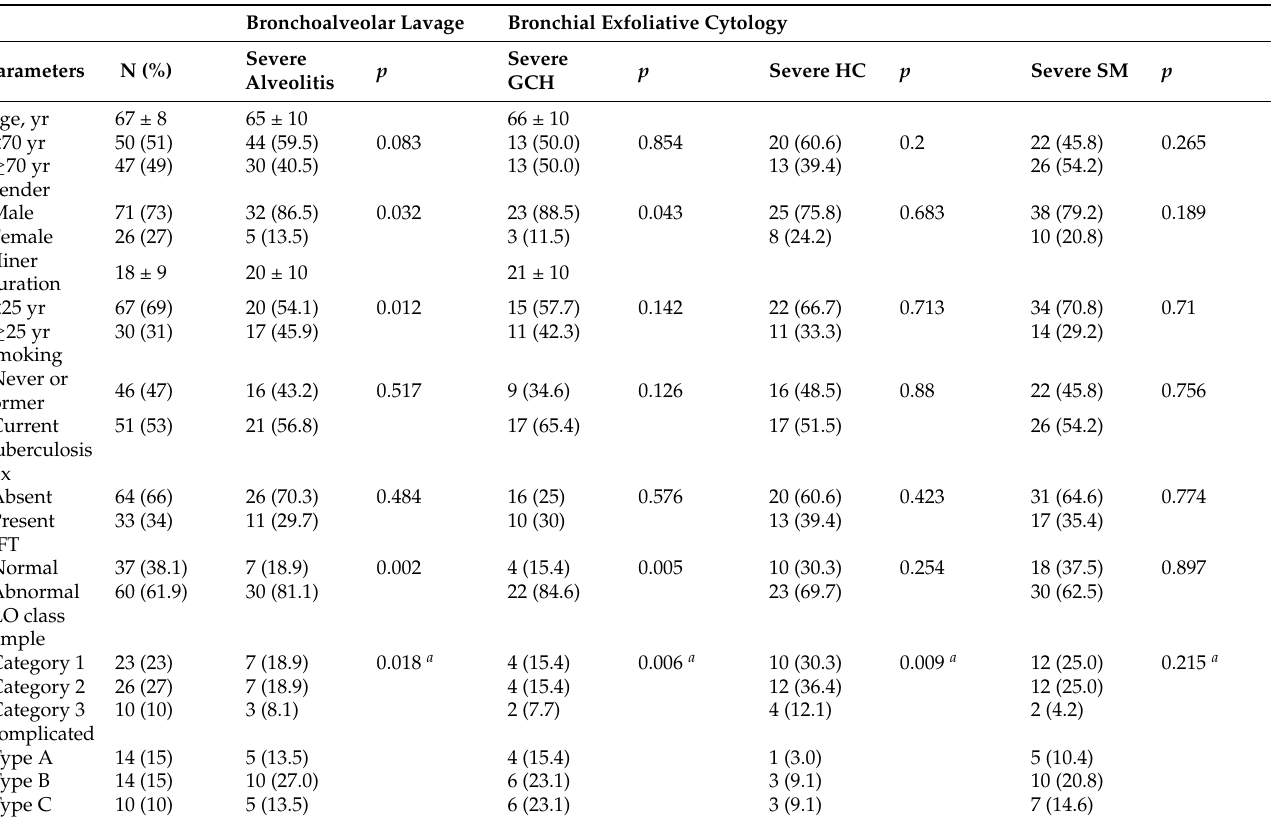
Table 4. Correlation between patient demographics and pulmonary exfoliative cytology findings in coal workers’